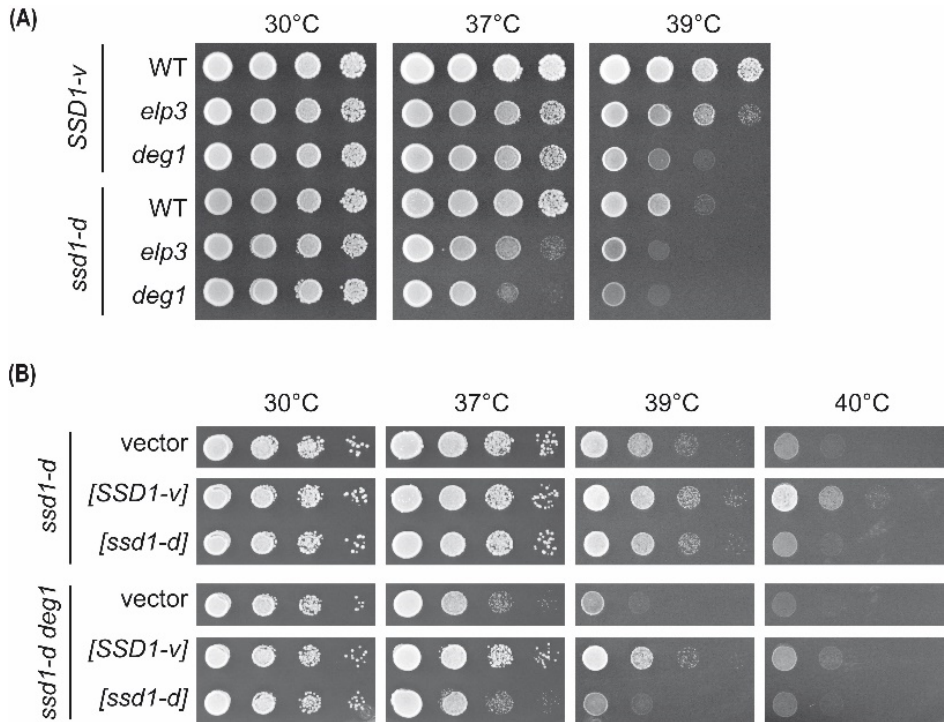
Figure 1. Temperature sensitivity of elp3 and deg1 mutants in the SSD1-v and ssd1-d strain backgrounds. ( A ) Wild type (WT) and indicated mutants were serially diluted, spotted on yeast extract–peptone–dextrose (YPD) plates, and incubated at the specified temperature for 48 h. ( B ) The WT and deg1 mutant in the ssd1-d background containing an empty vector, SSD1-v- , or ssd1-d -containing plasmids were serially diluted, spotted on YPD plates, and incubated at the indicated temperature for 48 h.